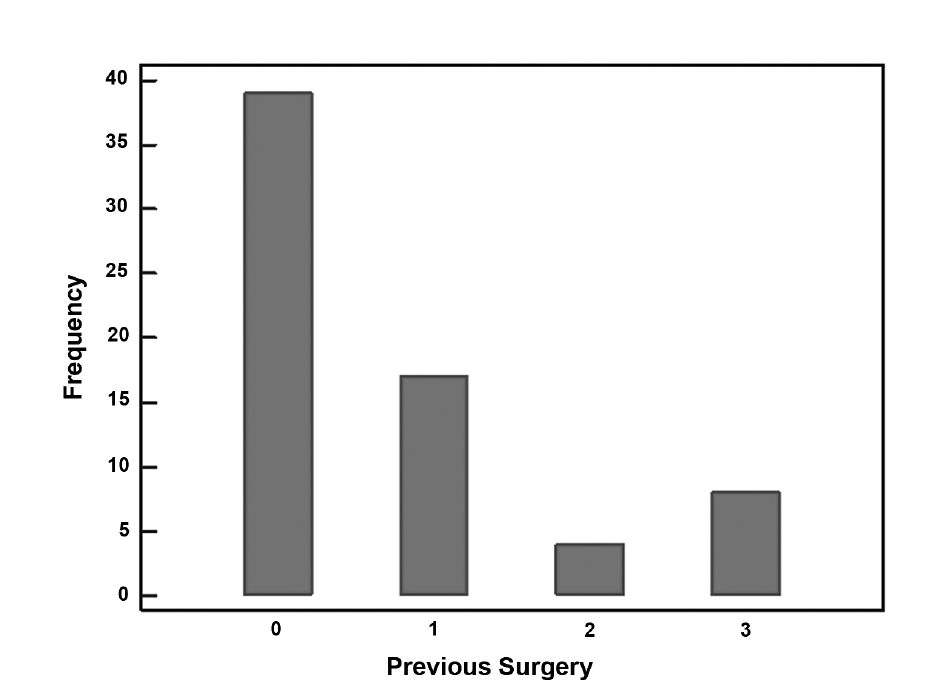
Figure 2 – Previous surgery. 0 = none; 1 = TVT; 2 = botox injection; 3 = prolapse